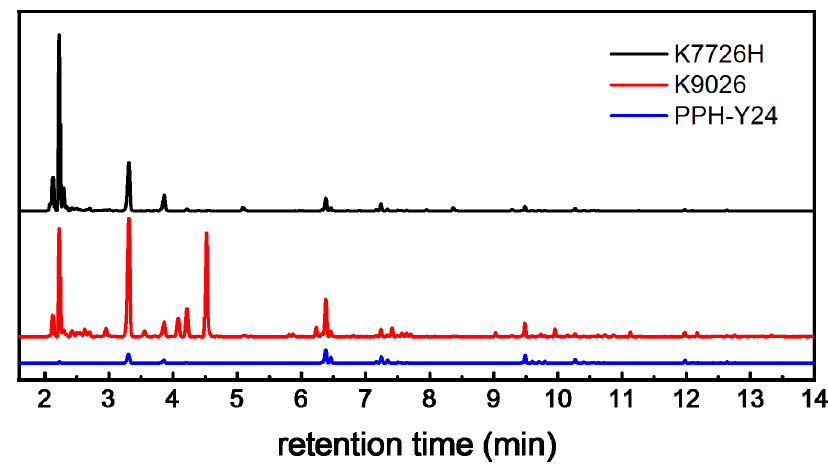
Figure 1. Gas Chromatography-Hydrogen Flame Ion Detector (GC-FID) chromatograms showing volatile organic compounds (VOCs) extracted by Headspace (HS) from neat PP resins (K7726H: the black line, K9026: the red line, PPH-Y24: the blue line).